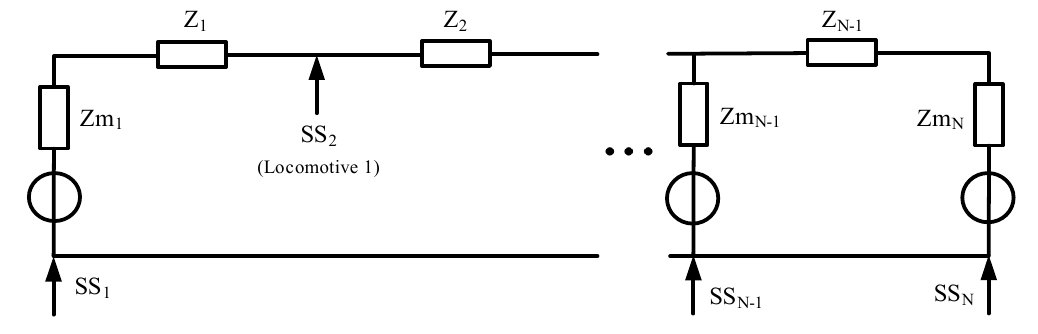
Figure 8. The equivalent mathematic model of ACTPSS.